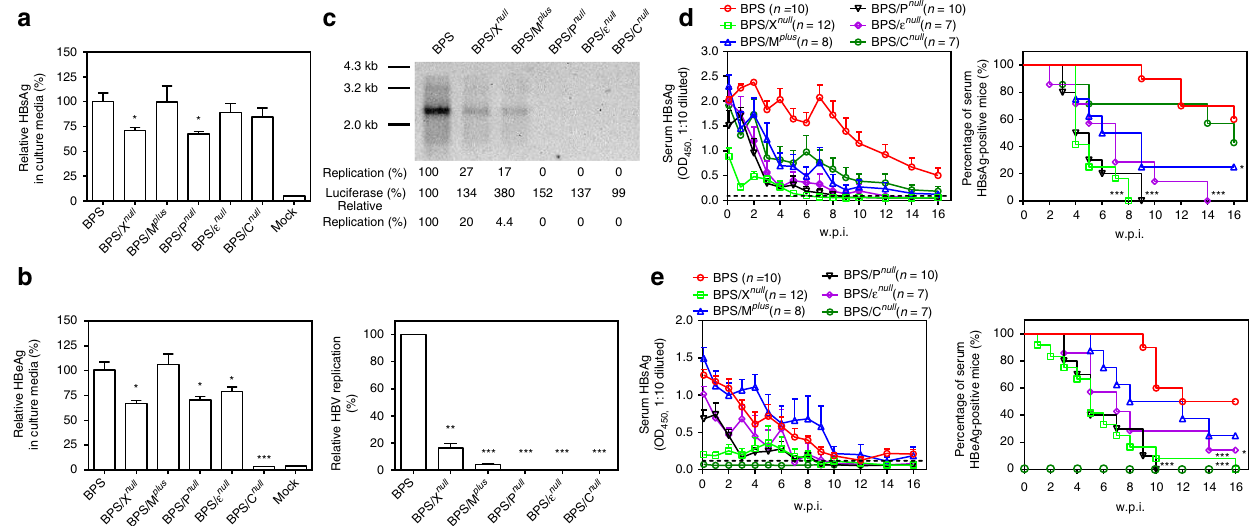
Fig. 3 Comparison between BPS and BPS-derived mutants in vitro and in vivo. BPS and BPS-derived mutants with prematurely terminated C (C null ), X (X null ), or P (P null ) ORFs, re-instated preS2 start codon (M plus ) or inactivated packaging signal ( ε null ) were transfected into Huh-7 cells and supernatants were assayed for HBsAg ( a ) and HBeAg ( b ) at 48 hrs post transfection. c Intracellular capsid-associated HBV DNA was analysed in Southern blot, and quanti fi ed using densitometry scanning. Transfection ef fi ciency was normalised by measuring luciferase expressed from co-transfected pGL3 plasmid and data were further normalised taking BPS measurements as 1. Transfections were performed in triplicates and repeated twice independently. Means and s.e. m. of the two repeats are plotted. c top panel shows representative Southern blot results. Plasmids were then used for HDI procedure on BALB/c mice. Sera were collected at indicated time points and analysed for HBsAg ( d ) and HBeAg ( e ). Group means and s.e.m. within group (left panels), as well as group positivity percentage data (right panels) are plotted with group sizes ( n ) indicated. Mutants ’ data are compared against wild type and statistical signi fi cance calculated using unpaired two-tailed t -test ( a , b , c , bottom panel) or log-rank (Mantel – Cox) test ( d , e , right panels). * p < 0.05; ** p < 0.01; *** p < 0.001. Dotted lines represent cut-off thresholds. w.p.i. weeks post